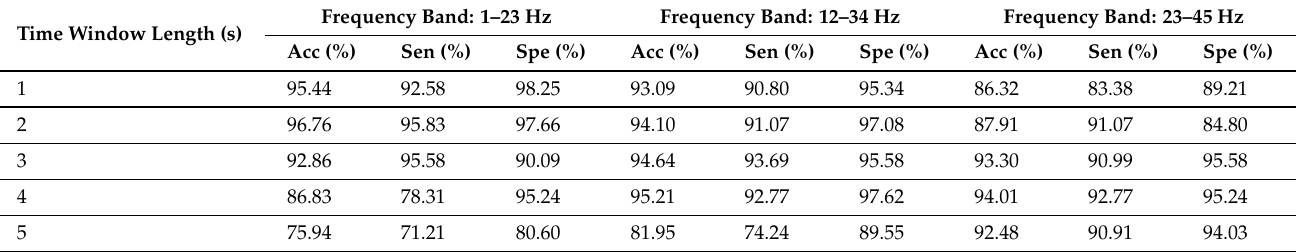
Table 9. The results of Experiment 3. Acc, Sen and Spe are the abbreviations for accuracy, sensitivity, and specificity, respectively. Time Window Length